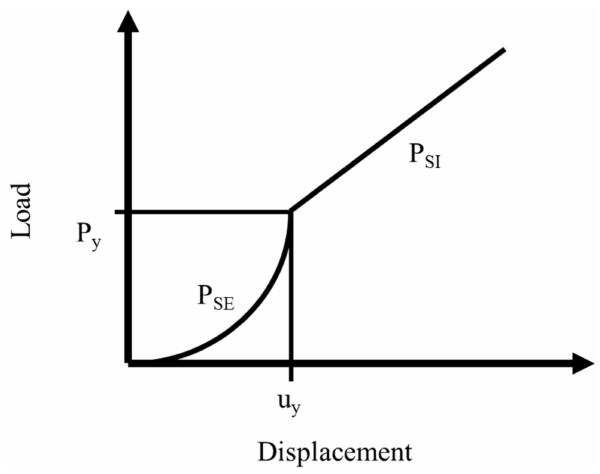
Figure 3. Static load-displacement